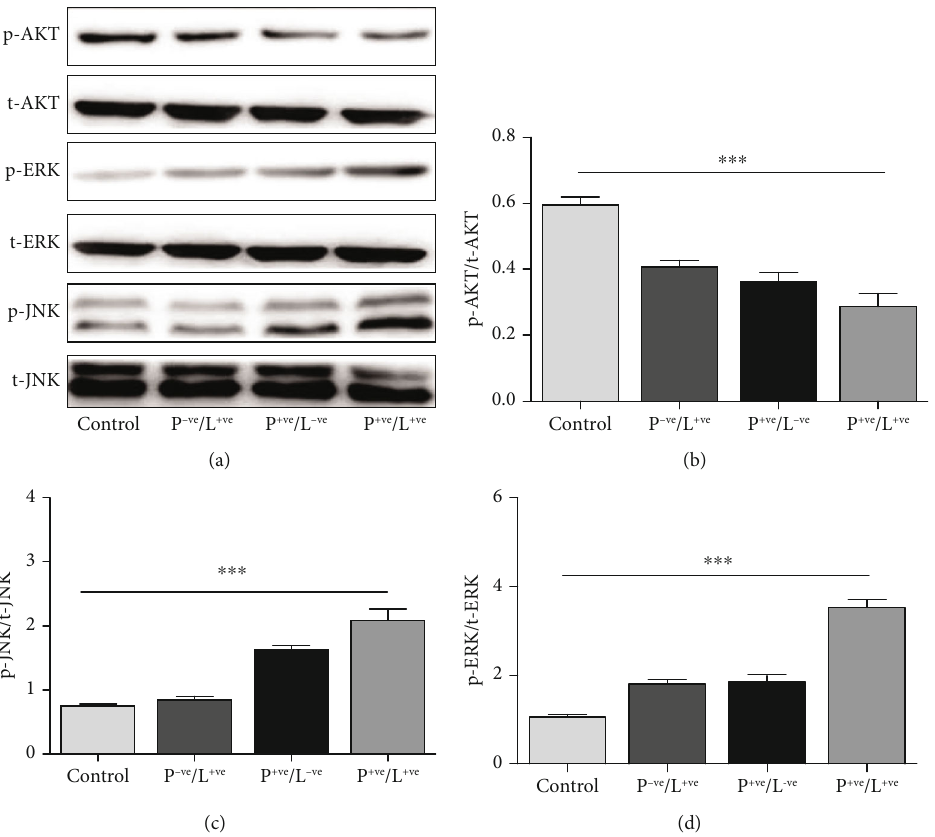
Figure 6: E ff ect of AE-mediated PDT on the Akt pathway and mitogen-activated protein kinases. (a) Western blotting analysis of Akt, JNK, and ERK following AE-PDT. The cells were treated with 5 μ M AE, irradiated for 10min, and protein lysates were collected 12h later for western blotting assays. β -Actin was used as an internal control. The graphs represent the quantitative analysis of the change of (b) p- Akt, (c) p-JNK, and (d) p-ERK ( ∗∗∗ p < 0 : 0001 ). Protein level was expressed as mean ± SD from three independent